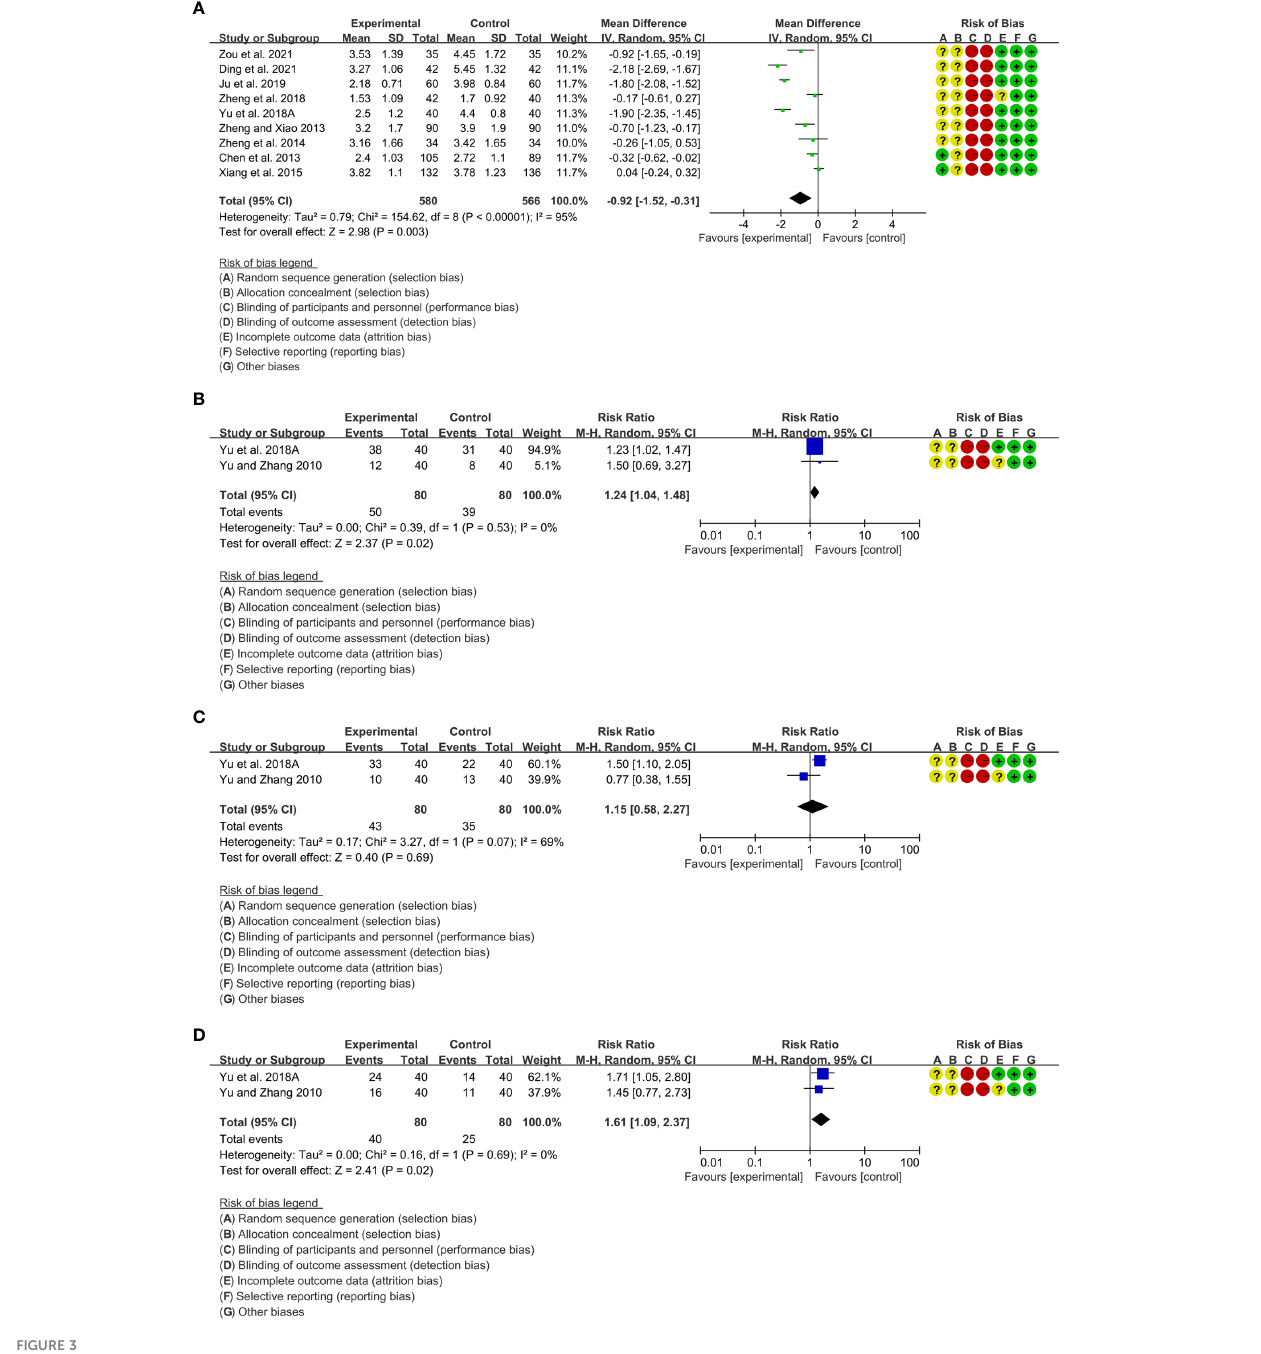
FIGURE 3 Ef fi cacy indicators of Total glucosides of paeony (A) DAS28; (B) ACR20; (C) ACR50; (D)